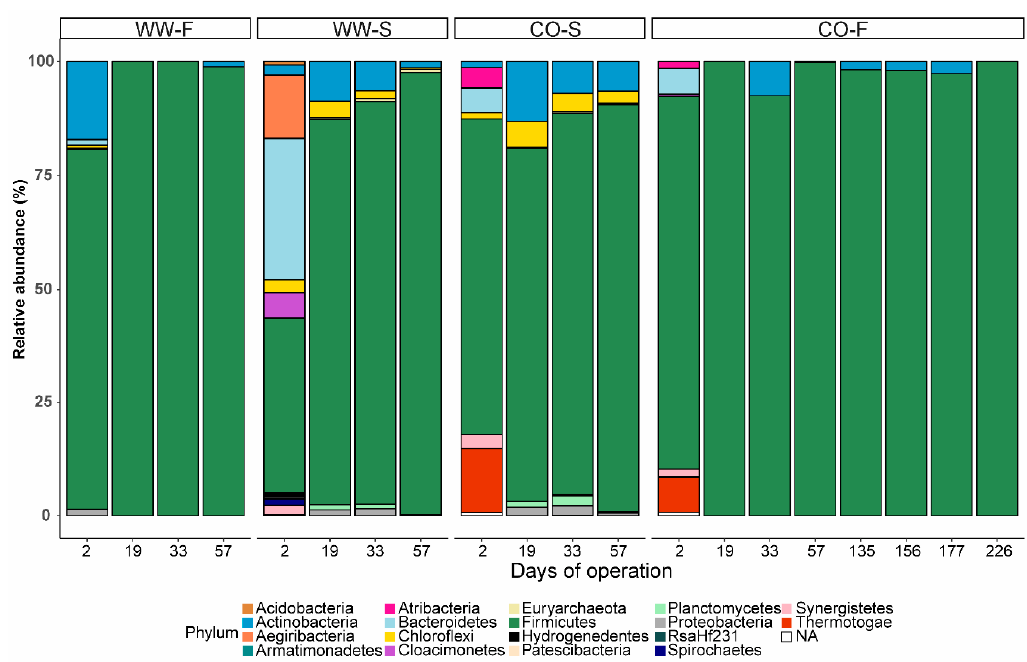
Figure 5. Principal coordinate analysis (PCoA) plot of microbial community structure using weighted UniFrac. Reactor parameters significantly associated with changes in microbial community structure are plotted as vectors, where the length and direction indicate the contribution of the variable to the principal components. Variable HRT stands for hydraulic retention time.